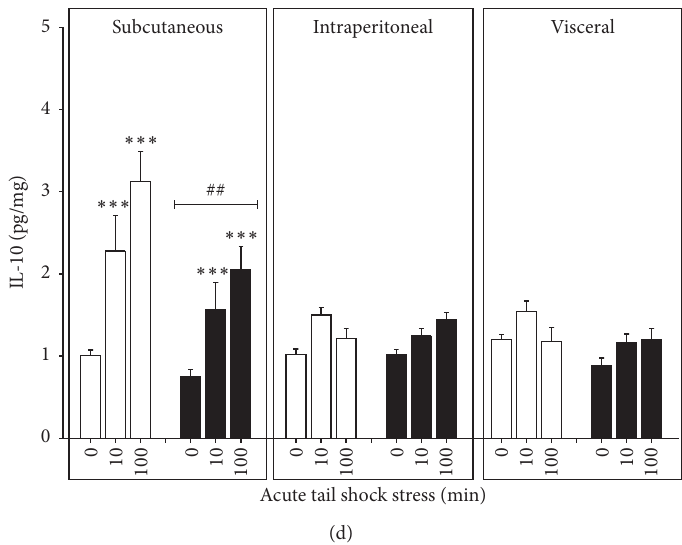
(d) Figure 2: Effect of a 24 h fast on the TNF- 𝛼 and IL-1 𝛽 response to 10 or 100 acute inescapable tail shocks in WAT. Fed (FED ◻ ) or fasted (FASTED ◼ ) rats were exposed to 0 (control condition), 10, or 100 acute, inescapable tail shocks (IS) and immediately sacrificed and subcutaneous, intraperitoneal, and visceral WAT were collected. Shown is the mean (+SEM) concentration of (a) tumor necrosis factor alpha (TNF- 𝛼 ); ∗∗ 𝑝 < 0.001 (0IS versus 10IS within WAT compartment), ## 𝑝 < 0.001 , ### 𝑝 < 0.0001 (main effect of FED versus FASTED within WAT compartment), and ## 𝑝 < 0.001 (FED + 10IS versus FASTED + 10IS within WAT compartment); (b) interleukin- (IL-) 1 beta (IL-1 𝛽 ), ∗∗∗ 𝑝 < 0.0001 (0IS versus 100IS within WAT compartment and fed condition) and ### 𝑝 < 0.0001 (FED + 100IS versus FASTED + 100IS within WAT compartment); (c) interleukin- (IL-) 6, ∗∗∗ 𝑝 < 0.0001 (0IS versus 100IS within WAT compartment); (d) IL-10, ∗∗∗ 𝑝 < 0.0001 (0IS versus 10 or 100IS within WAT compartment), and ## 𝑝 < 0.001 (main effect of FED versus FASTED within WAT compartment).